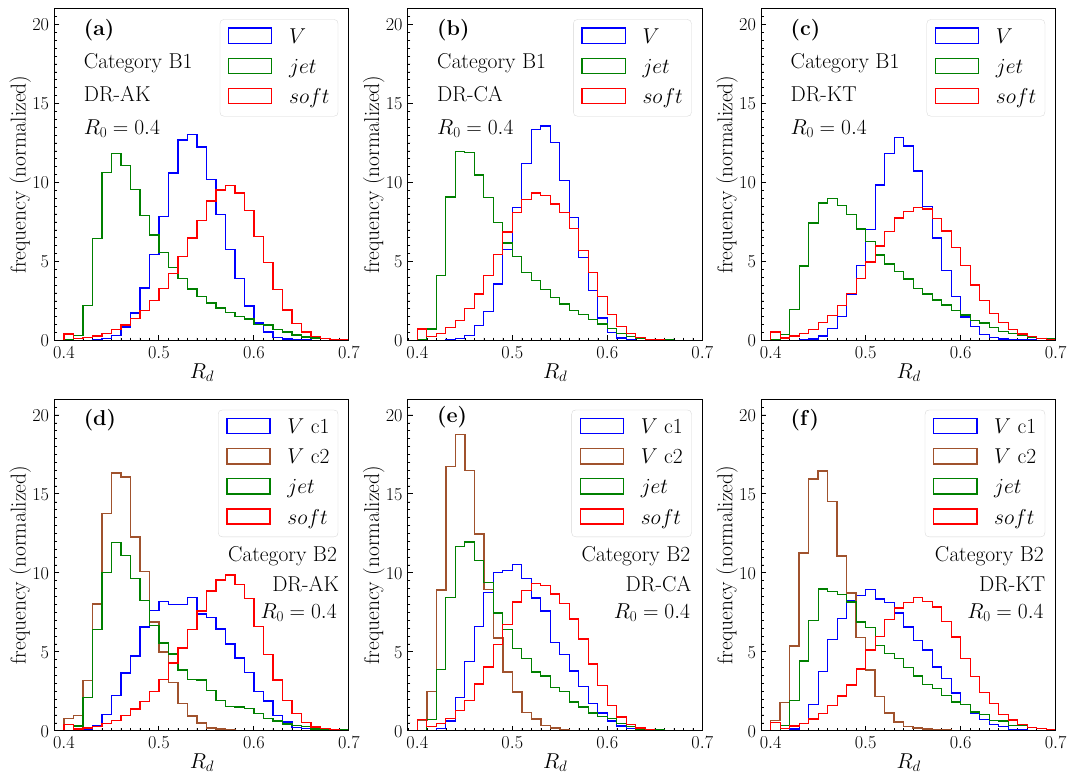
Figure 8 . Normalized distribution of final radius R d for the three different types of jets. The top panel represents the distributions of R in the category B1 events and the whole bottom panel is d for category B2 events. The conventions for the colours and labels V , jet , and soft are the same as figure 7. For category B2 events, ‘ V c1’ and ‘ V c2’ labels represent the two constituent jets of the reconstructed vector bosons. The distributions are shown for DR-AK, DR-CA, and DR-KT algorithms in the panels (a,d), (b,e), and (c,f), respectively, with R = 0 . 4 . 0